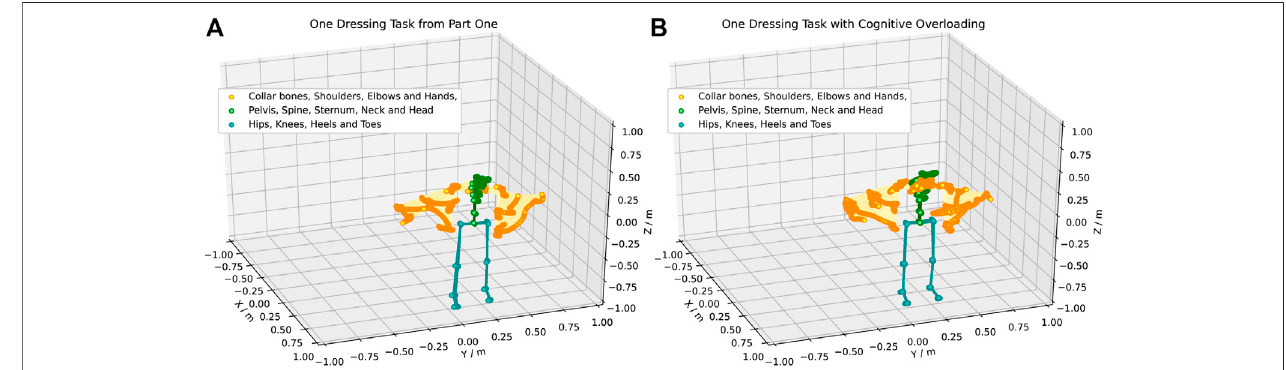
FIGURE 3 | An example of the human movement recorded using the XSens motion capture suit. (Panel A) shows the movement of one participant during one dressingiterationperformedinPartOne. (PanelB) showsthemovementofthesameparticipantduringonedressingiterationperformedinPartTwoduringthe cognitive overloading